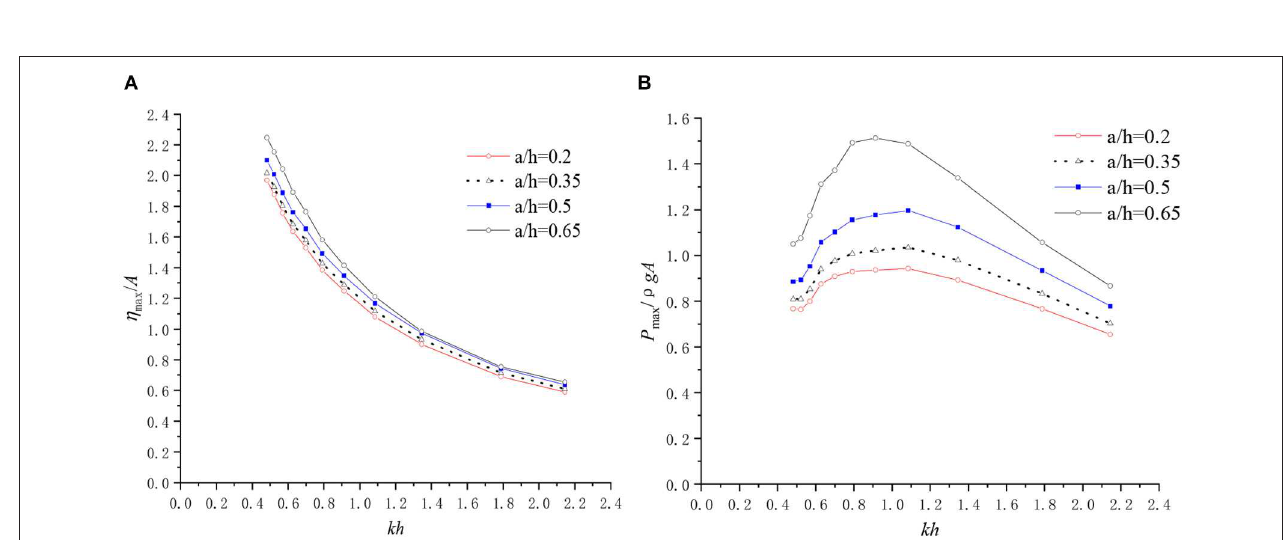
FIGURE 11 | Hydrodynamic conversion efficiency vs. dimensionless wave number for different step heights.